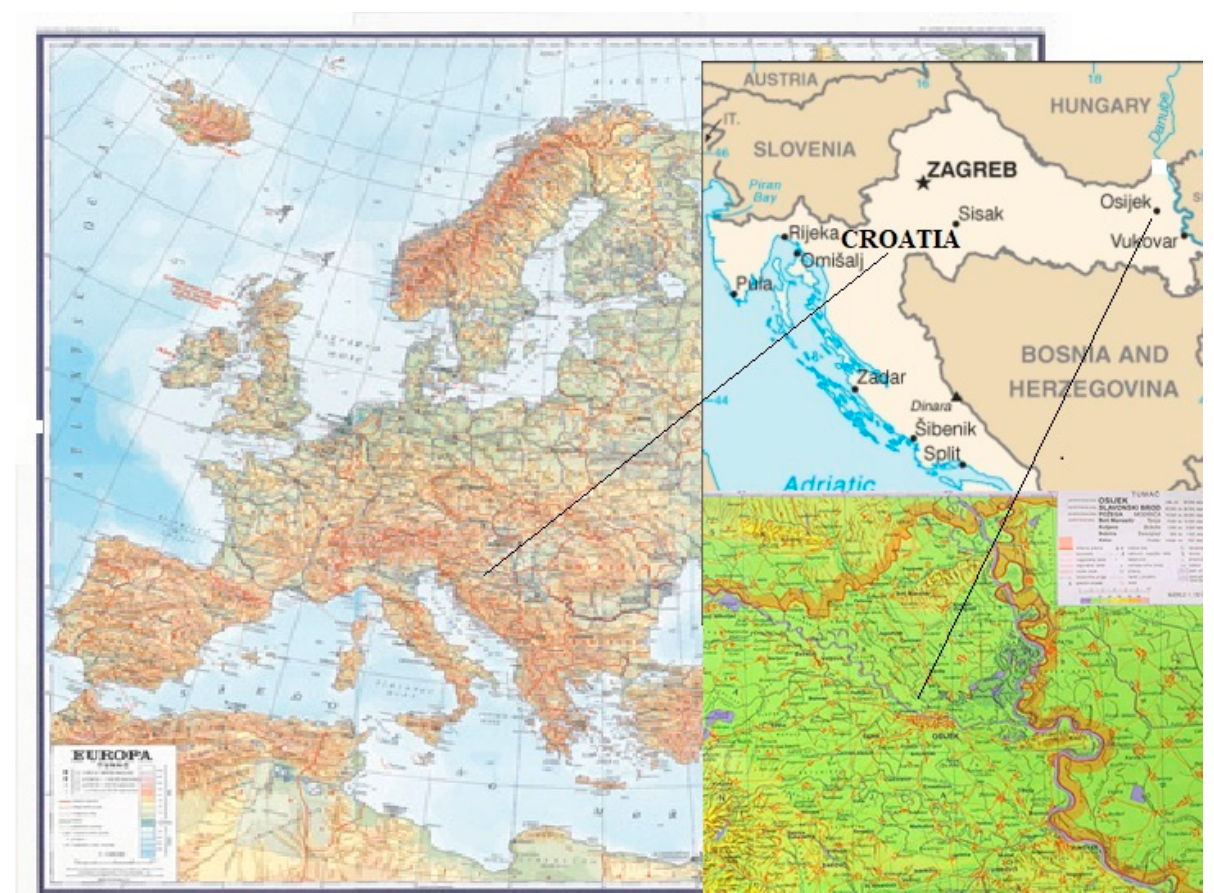
Figure 1. Study area: Europa—Croatia-Osijek (45°33 ′ N 18°41 ′ E/45.55° N 18.68° E—geographic coordinates Osijek, Croatia).